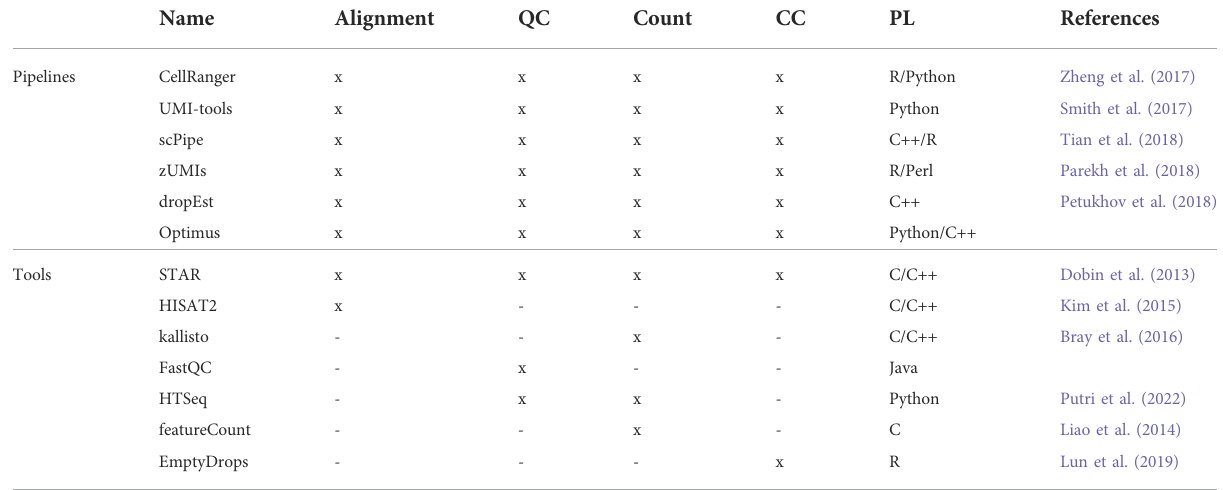
TABLE 1 Raw data processing